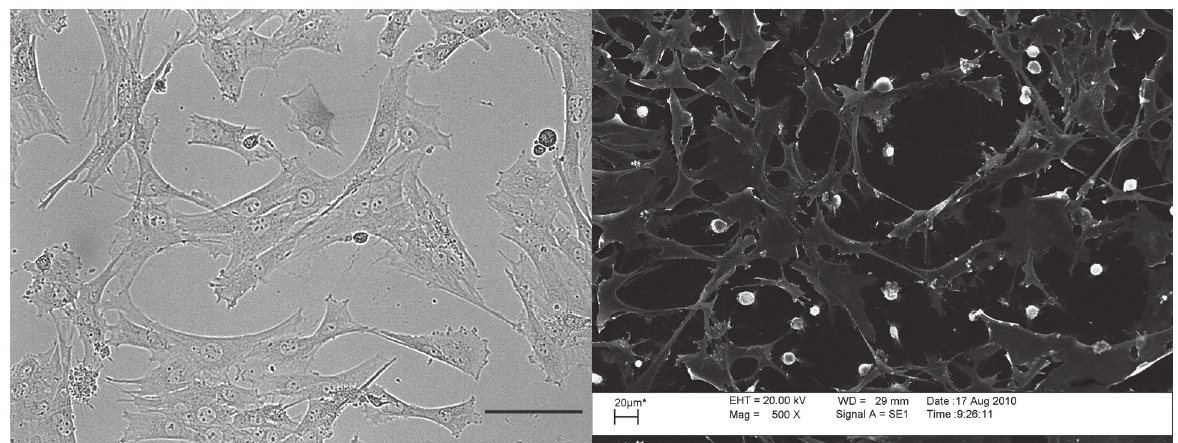
Figure 1 - Culture of mesenchymal stem cell in forth passage, with higher cell confluence and fibroblastoid-like cells adhered to the substrateand the culture flask. A) Photomicrograph captured of inverted optical microscope (escale = 50µm). B) Photomicrograph captured of scanning electron